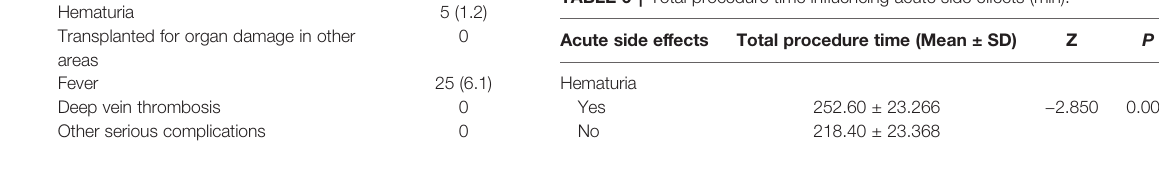
TABLE 6 | Total procedure time in fl uencing acute side effects